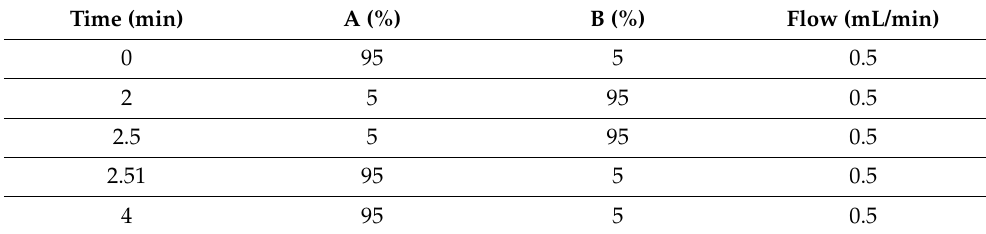
Table 2. Binary pump program used for linear gradient elution with mobile phases A and B. Time (min) A